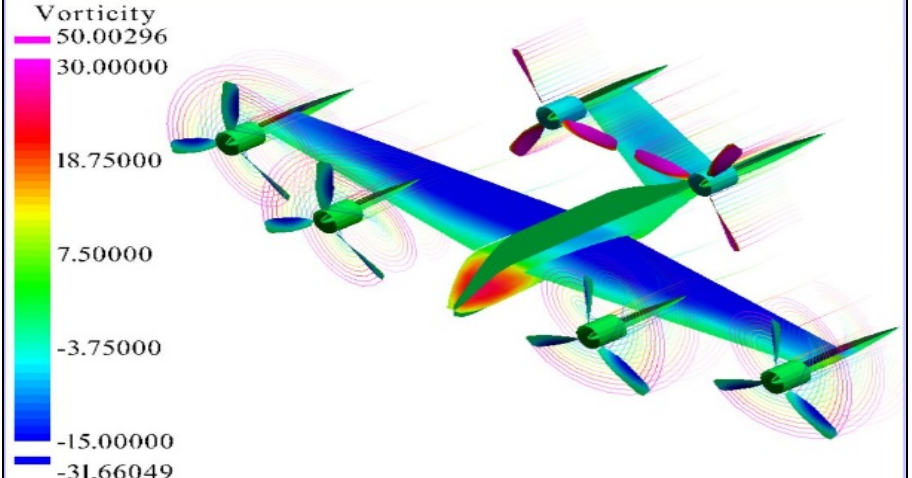
Figure 31. Vorticity contour.